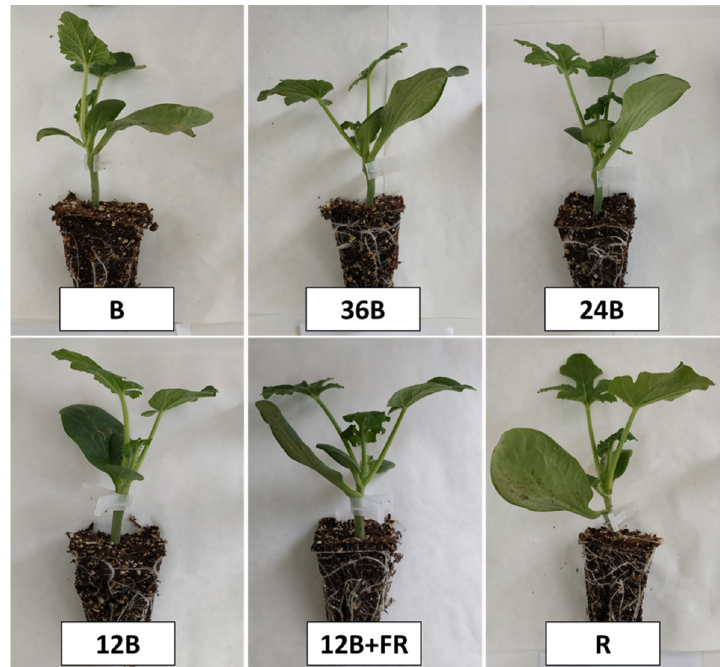
Figure 1. Grafted watermelon seedlings after healing in a chamber under six different light treatments for 7 days, and after acclimatization in a greenhouse for 7 days. B: narrow-band blue; 36B: 36% blue and 64% red; 24B: 24% blue and 76% red; 12B: 12% blue and 88% red; 12B+FR: 12% blue, 83% red, and 5% far-red; R: narrow-band